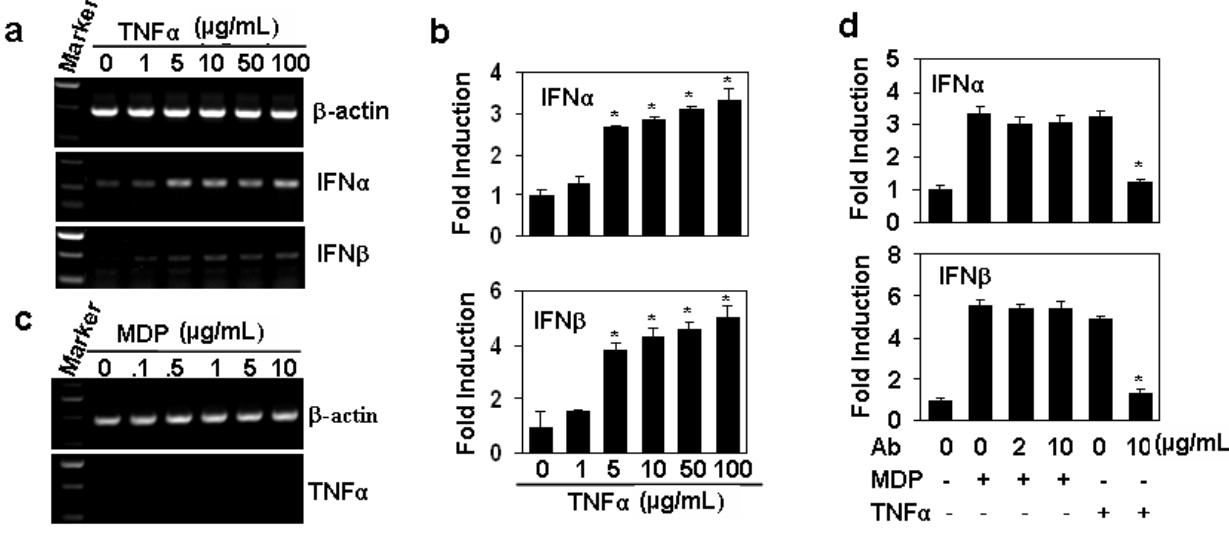
Figure 3. The up-regulation of the gene expression of interferons is TNF α -independent. ( a ) TNF α induced the up-regulation of interferon gene expression. HAECs were treated with indicated concentrations of TNF α for 24 h. The gene expression of IFN α and IFN β was measured by RT-PCR. β -actin gene expression was measured as loading control; ( b ) The quantitation of interferon gene expression in (A) by qRT-PCR. * P < 0.05 compared with the control groups, n = 3 in each group; ( c ) The effect of MDP on TNF α expression. HAECs were treated with the indicated concentrations of MDP for 24 h. The gene expression of TNF α was measured by RT-PCR. β -actin gene expression was measured as loading control; ( d ) The effect of TNF α neutralizing antibody on MDP induced induction of interferon gene expression. HAECs, pre-treated with indicated concentrations of anti-TNF α neutralizing antibody for 30 min, were re-stimulated with 10 µg/mL MDP for 24 h. The gene expression of IFNs was measured by real-time RT-PCR. * P < 0.05 compared with TNF α -treated groups, n = 3 in each